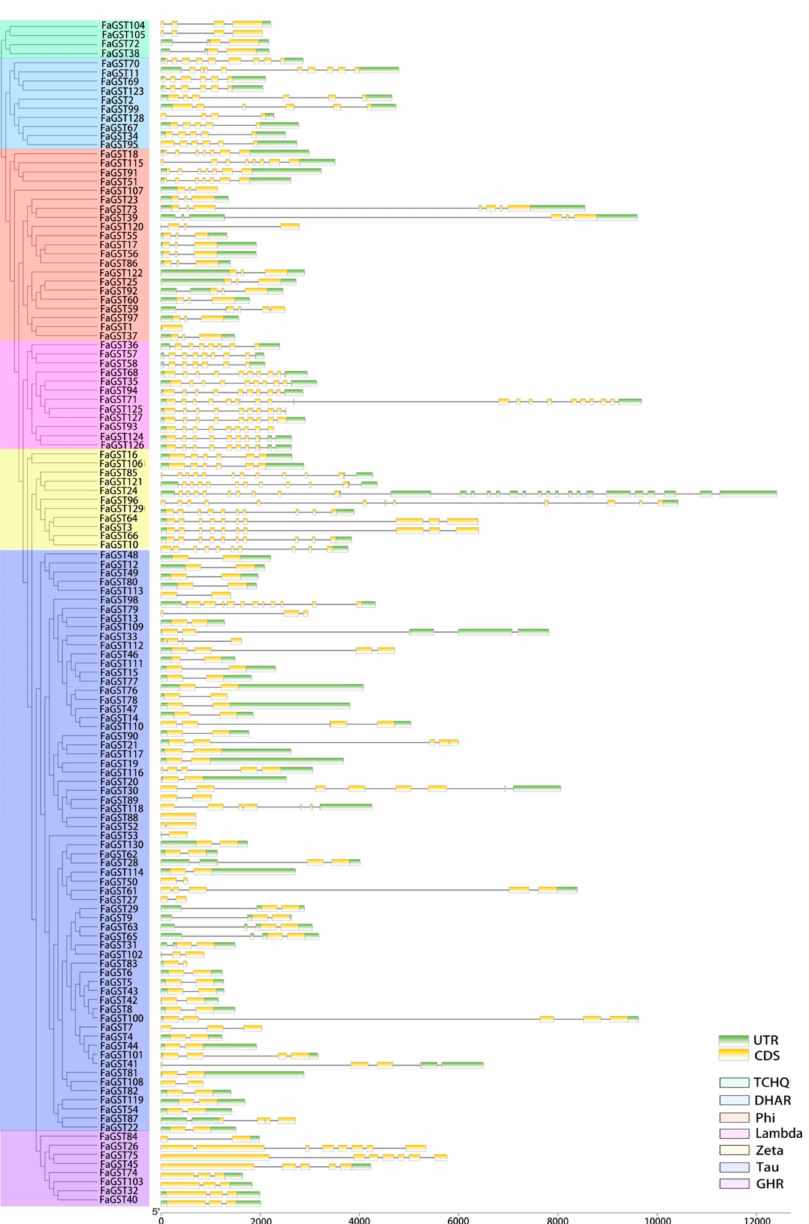
Figure 3. Exon–intron structures of FaGST genes. The cladogram was constructed by MEGA X software using the full-length of FaGST proteins. The exons and introns were represented by yellow blocks and black lines, respectively, the green blocks indicated the 5 (cid:48) and 3 (cid:48) UTR of the FaGST genes. Di ff erent colors indicated the di ff erent GST